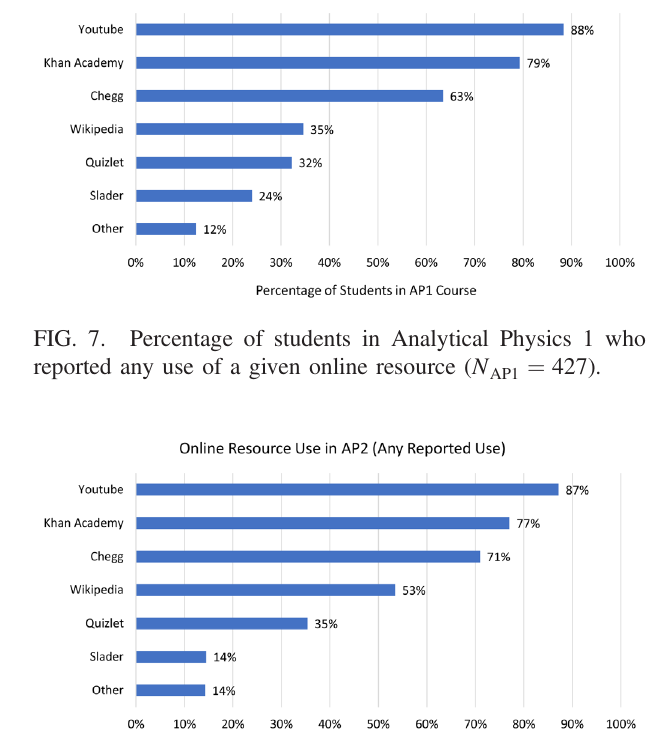
FIG. 5. Students ’ reported usage frequency of any online